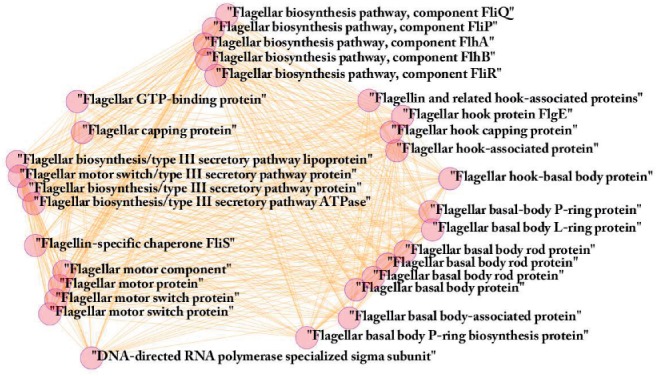
The flagellum-related cluster. This cluster contains 30 highly connected COGs (the nodes in the figure), all flagellar-related and is the biggest cluster of co-evolutionary genes